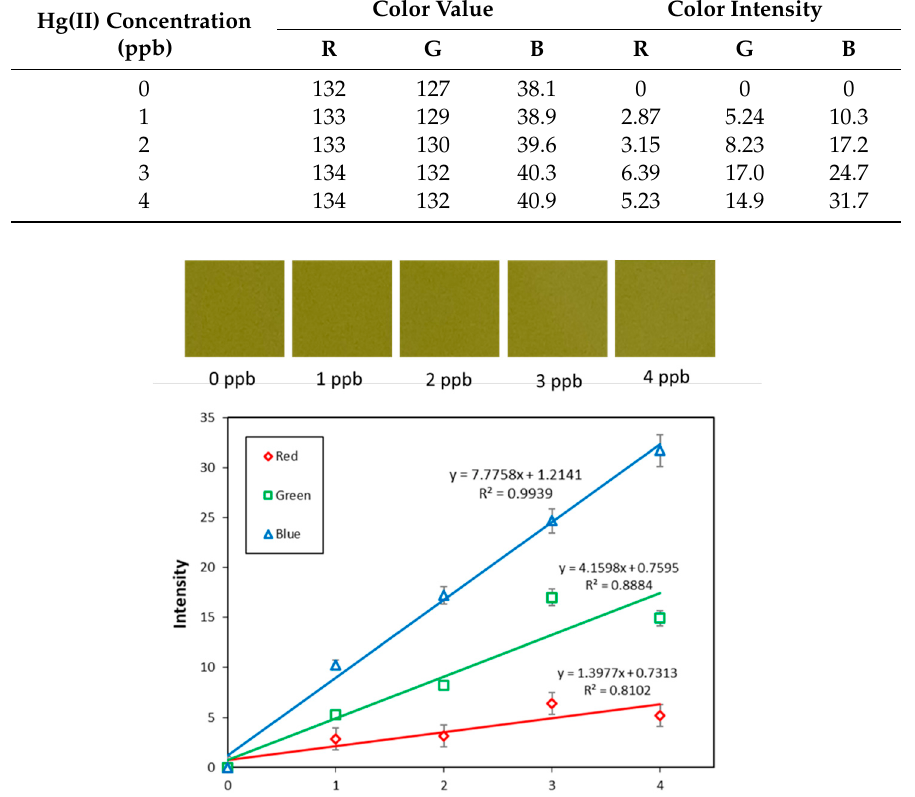
Table 1. RGB color value and intensity of the mercury calibration curve at the ppb level.